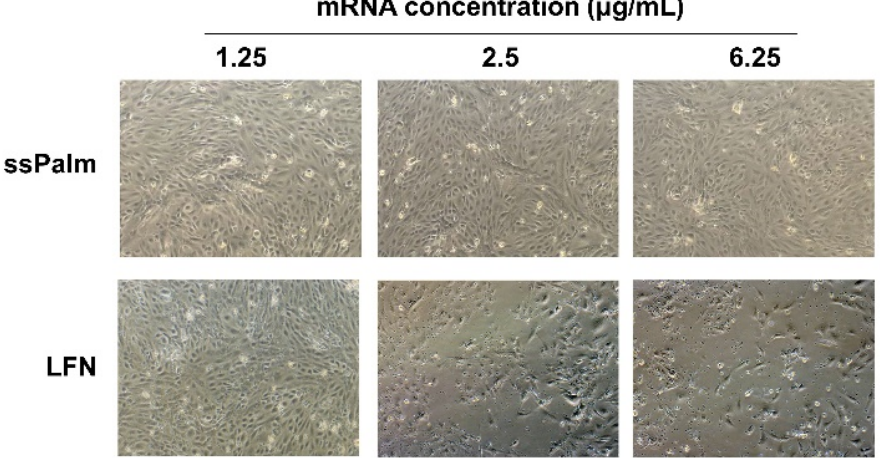
Figure 4. Microscopic observation of hCMEC/D3 cells after the treatment with ssPalm-LNP and